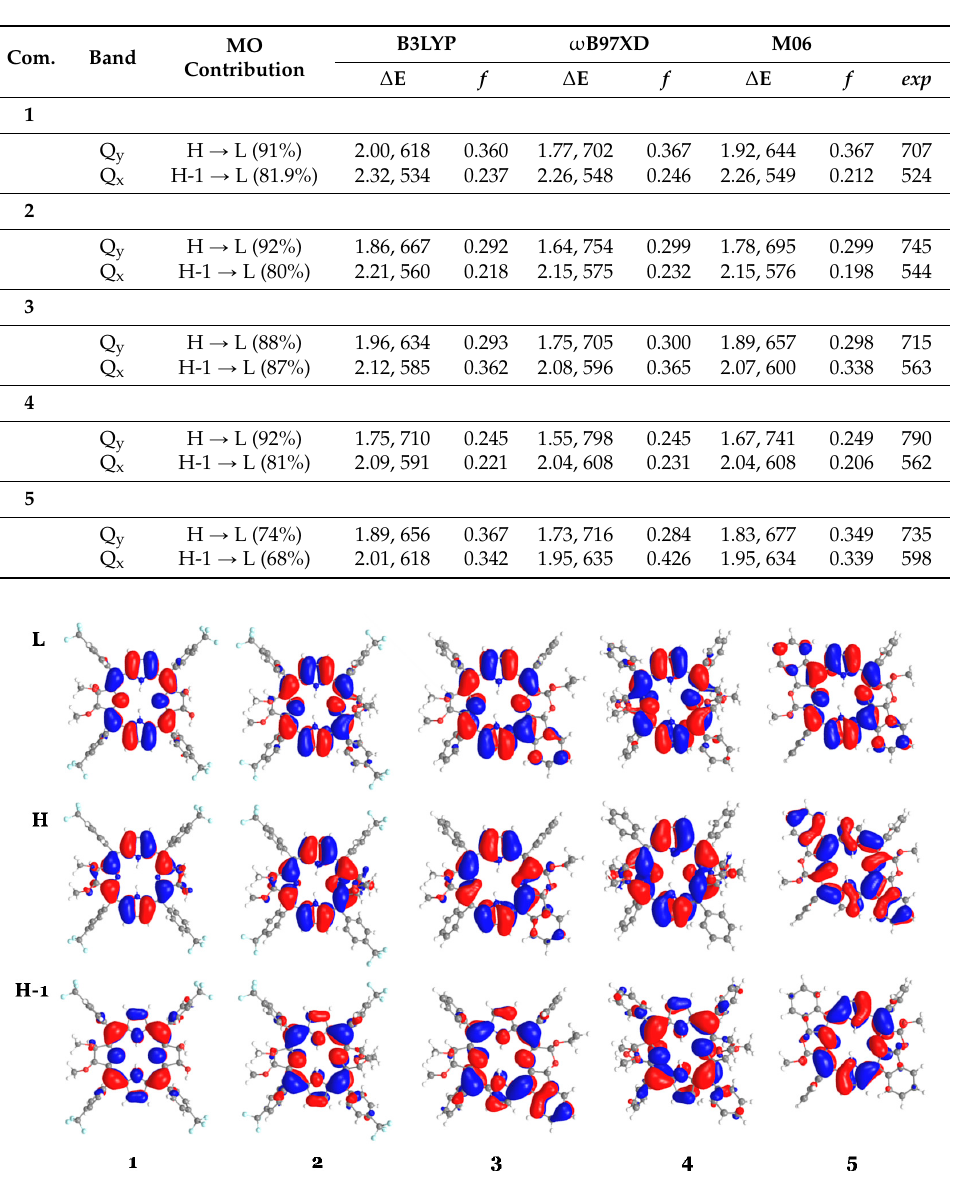
Figure 3. Graphical representation of the HOMO-1, HOMO and LUMO for compounds 1 – 5 computed at B3LYP/6-31G* level of theory.